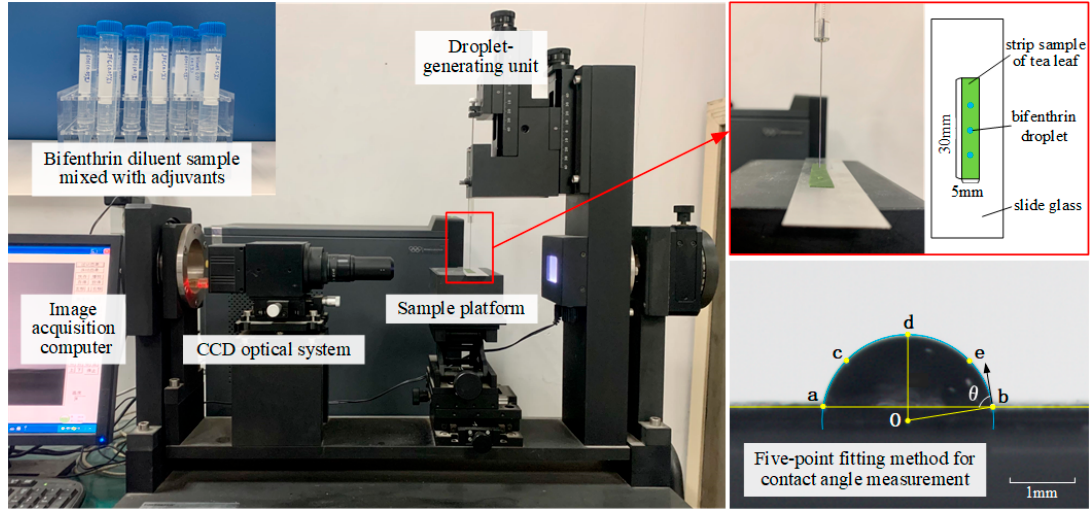
Figure 2. Schematic diagram of contact angle measurement process.